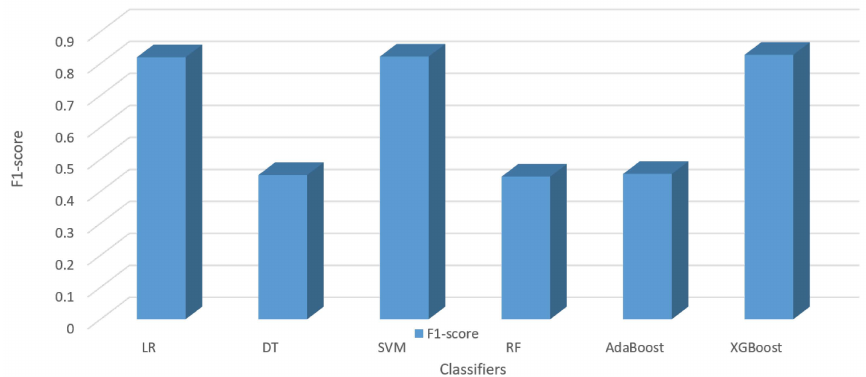
Figure 6. Evaluation results for the classifiers